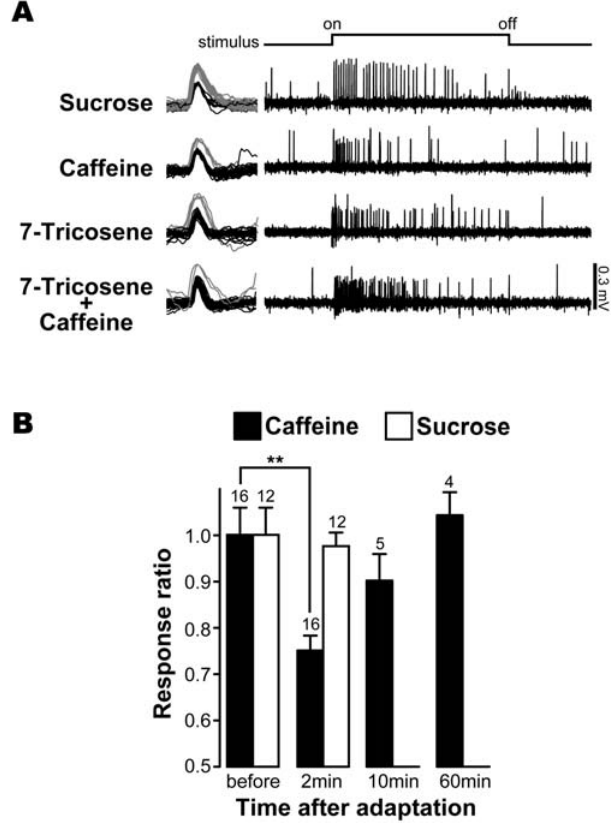
Figure 4. Caffeine and 7-T are detected by the same gustatory sensory neuron in i-type sensilla. (A) Above: 50 mM sucrose stimulated the L1 cell (on the left, spikes shown in gray=0.2–0.3 mV). Below: in the same sensillum, caffeine excited the L2 cell, while 10 2 8 M 7-T elicited a single class of spikes with an amplitude equivalent to those from the L2 cell (black spikes shown on the left=0.1–0.2 mV). Bottom: a mixture of caffeine and 7-T (with similar concentrations as above) elicits high levels of activity in a single class of spikes. This indicates that 7-T activates the L2 cell but not the L1 cell. Recordings are shown for 4 sec and the stimulus application lasted for 2 sec. n=10 (obtained with 5 male flies). ( B ) Caffeine and 7-T show cross-adaptation. Neuronal responses to caffeine were reduced following pre-stimulation with 7-T, supporting the hypothesis that 7-T and caffeine are detected by the same taste neuron. This effect was highly significant two minutes after pre-stimulation with 7-T (**: p =0.0016; two tailed paired t-test). In contrast, the response to sucrose remained unaffected by pre- stimulation with 7-T. The response ratio was calculated from the number of spikes induced by a given substance, before and after prestimulation. The filled bar represents the response of the L2 cell to caffeine; the empty bar represents the response of the L1 cell to sucrose. The numbers represent the number of stimulated sensilla (each recording was made with a different